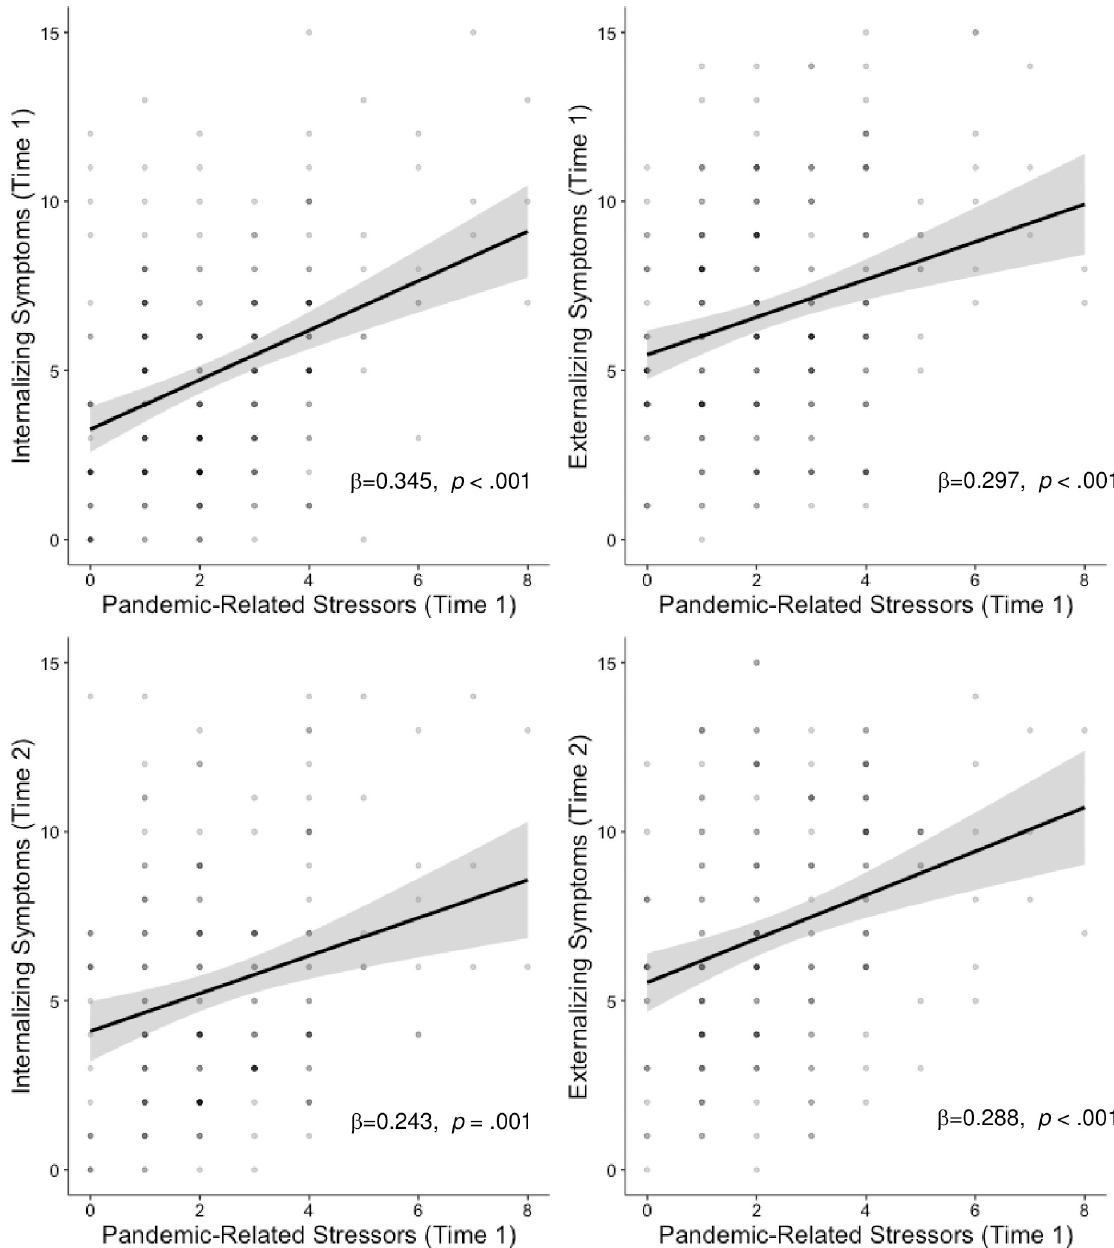
Fig 1. Main effects of pandemic-related stressors and psychopathology. All analyses control for age, sex, income-to-needs and pre- pandemic psychopathology symptoms.